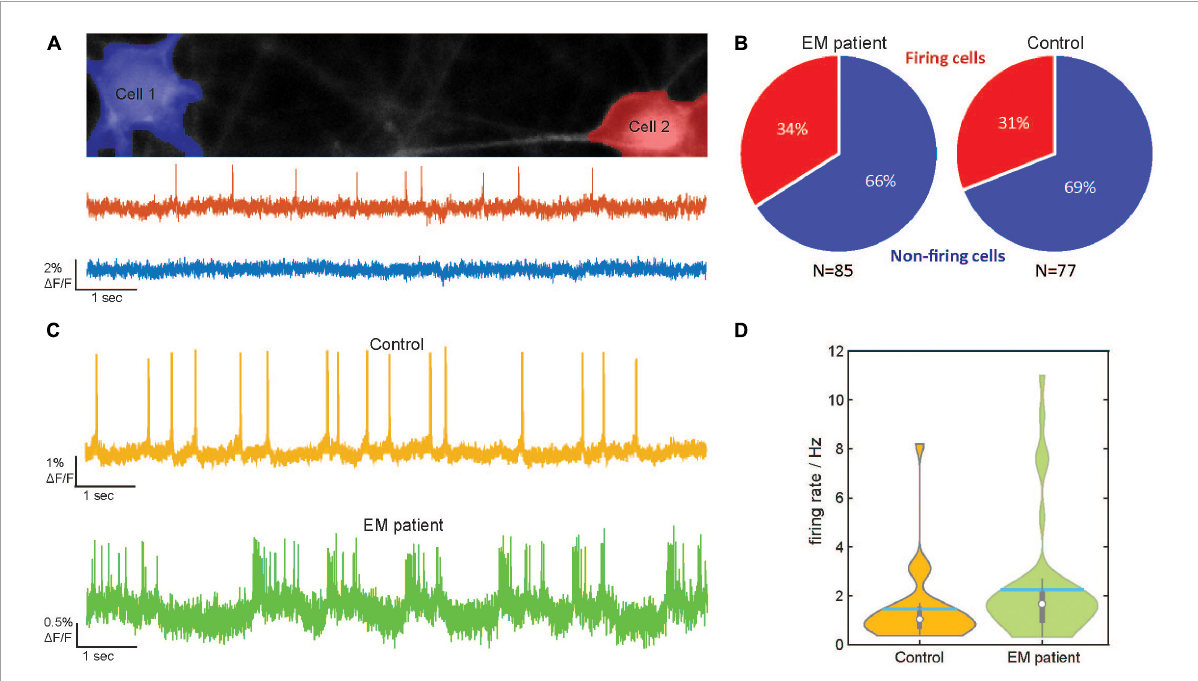
FIGURE2 Optical detection of spontaneous spiking in human induced pluripotent stem cell -derived sensory neurons (hiPSC–SNs) from an erythromelalgia (EM) patient and control. (A) Top: Images of two (Cell 1 in blue and Cell 2 in red) control hiPSC–SNs expressing dark quencher hybrid genetically encoded voltage indicator (dqGEVI). Somata were detected with an automated soma detection and evaluation procedure. Bottom: Raw imaging traces of cell 1 (blue) and cell 2 (red). (B) Pie-graphs showing the percentage of spontaneously firing cells from EM patient (Total N = 85, active N = 29) and control (Total N = 77, active N = 24). (C) Representative raw imaging traces of spontaneous firing behavior of hiPSC-SNs from the EM patient (bottom) and control (top). (D) Violin plots of the firing rate distribution in the EM patient human induced pluripotent stem cell-derived sensory neurons (hiPSCdSNs) ( N = 45) and the control hiPSCdSNs ( N = 27). The thin vertical black line indicates the 95% confidence interval. The thick vertical black line indicates the interquartile range. The median is indicated by the white dot. Spiking frequency is significantly higher in hiPSCdSNs from EM patients (Wilcoxon Rank test, WRT, p =